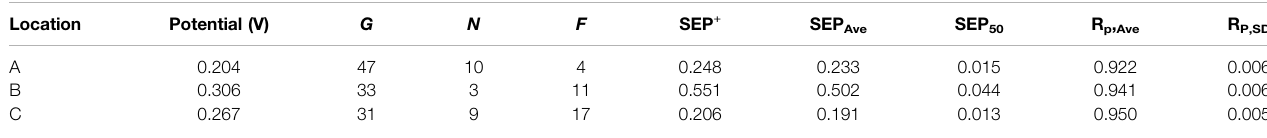
TABLE 2 | The parameters and prediction effects of the optimal EC-PLS models for three locations of soils. Location Potential (V) G